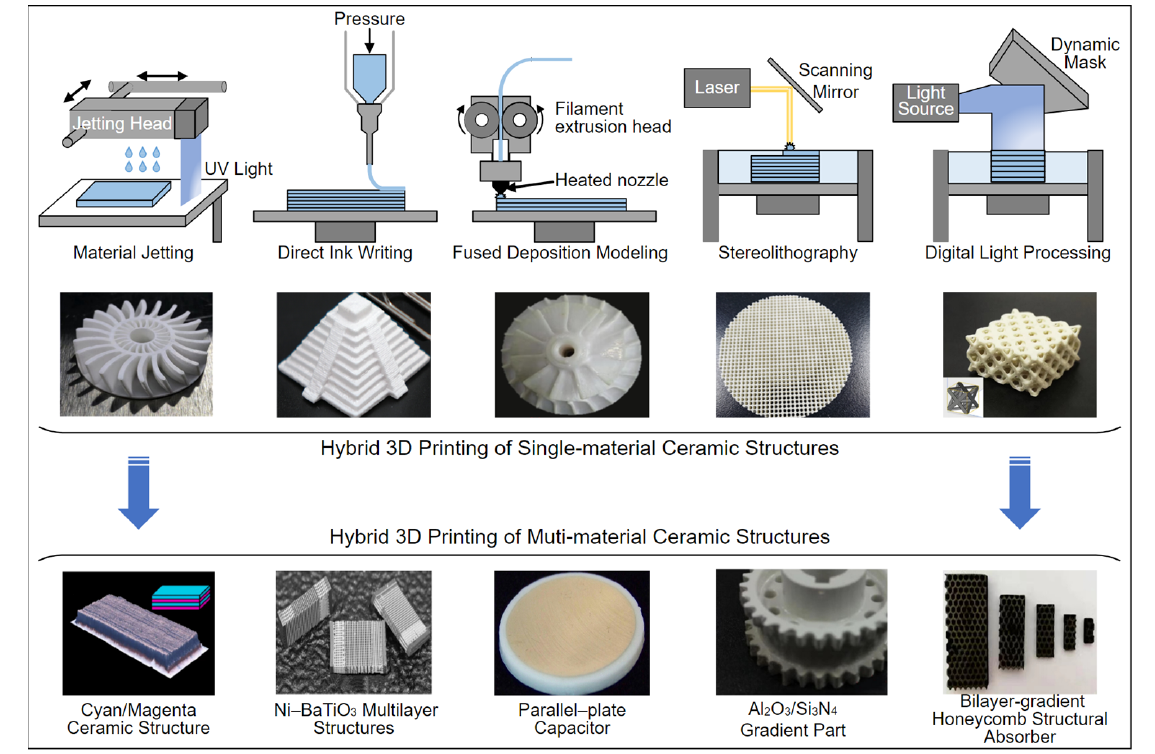
Figure 2. Schematics of five different 3D printing techniques, including material jetting (MJ), direct ink writing (DIW), fused deposition modeling (FDM), stereolithography (SLA), and digital light processing (DLP), and their applications in single material and multi-material ceramic 3D structures. Schematic images are adapted from [12–19,21–23].